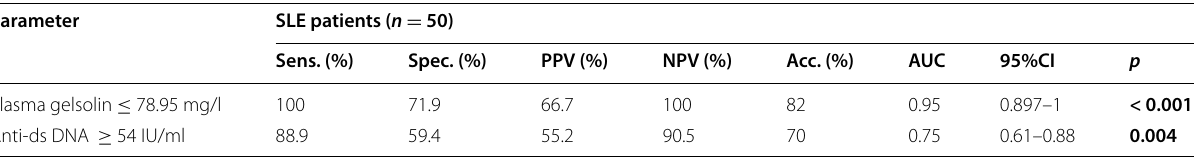
Bold values are significant at p